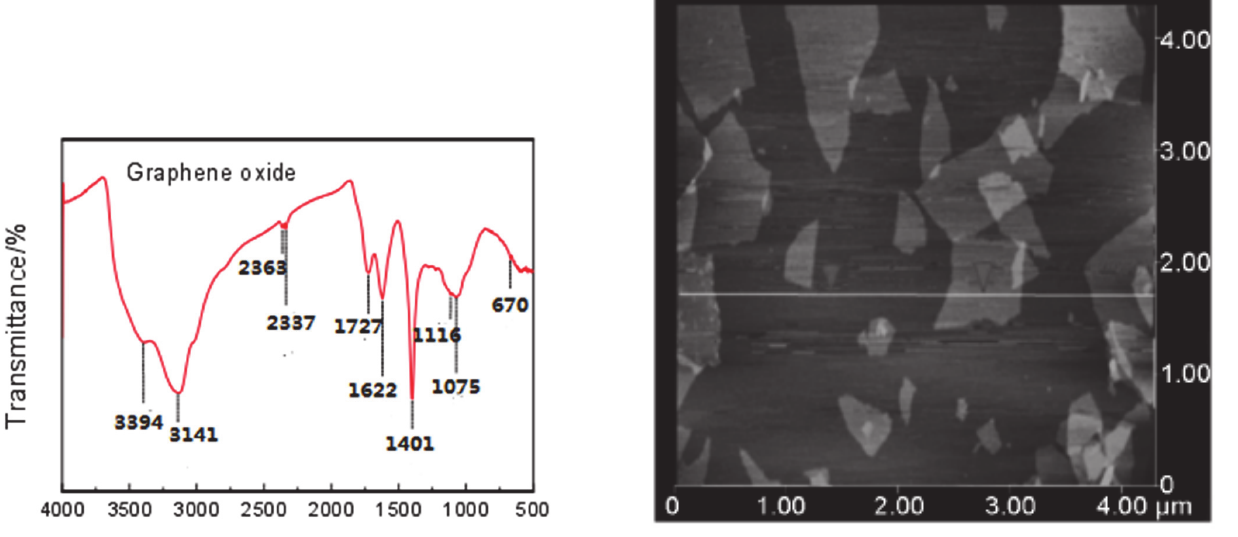
Figure 2 : The FTIR spectrum of graphite oxide. Figure 3. AFM image of graphene oxide